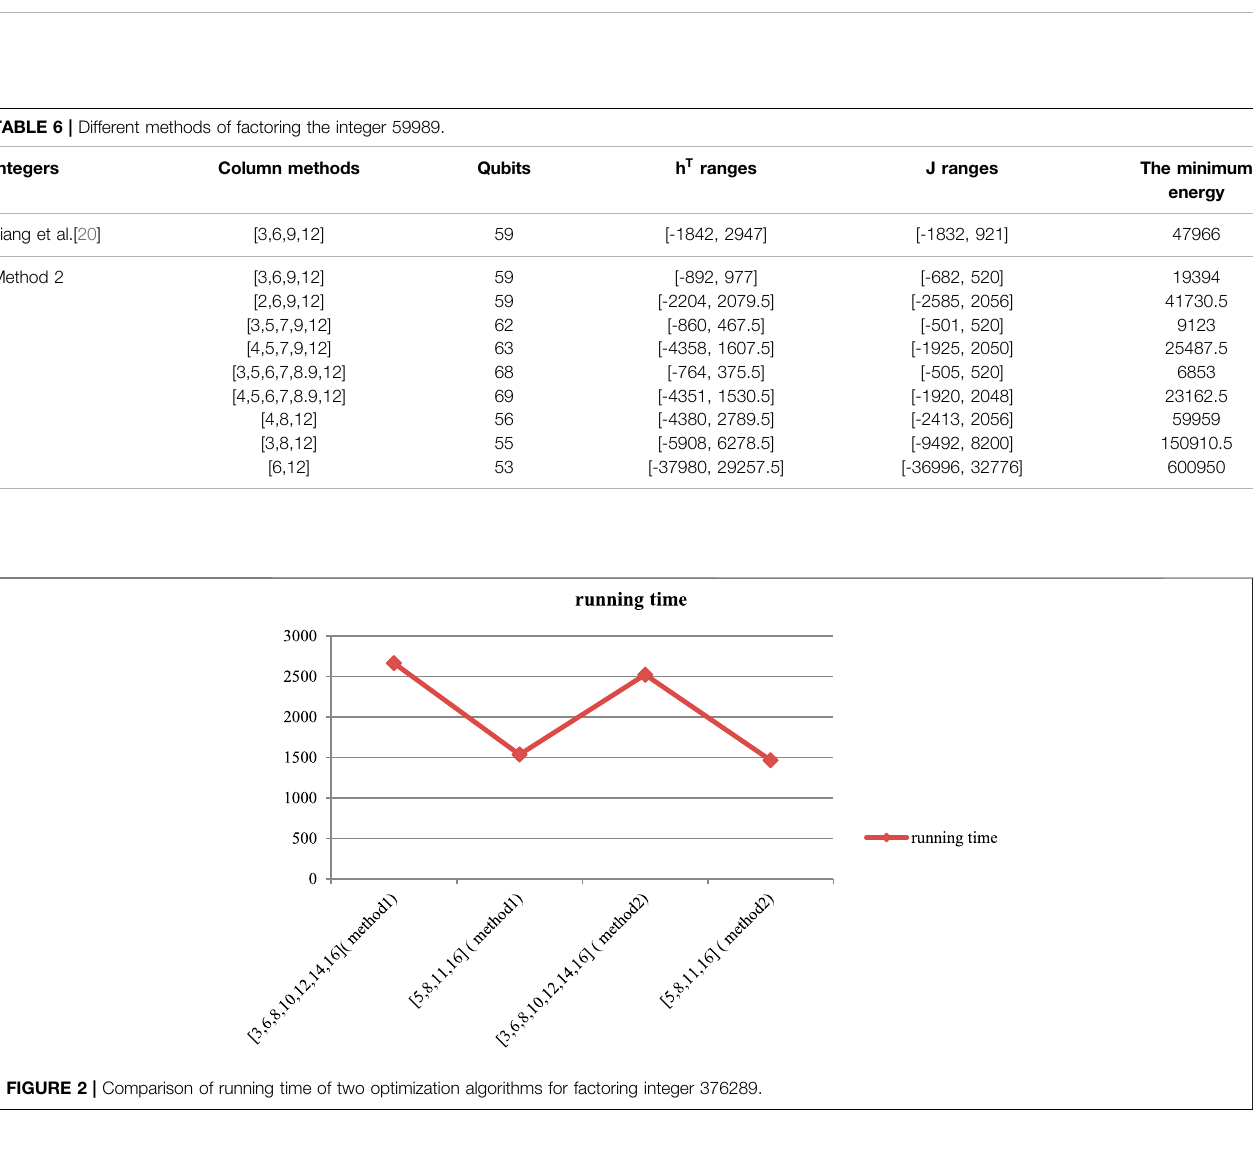
Frontiers in Physics |